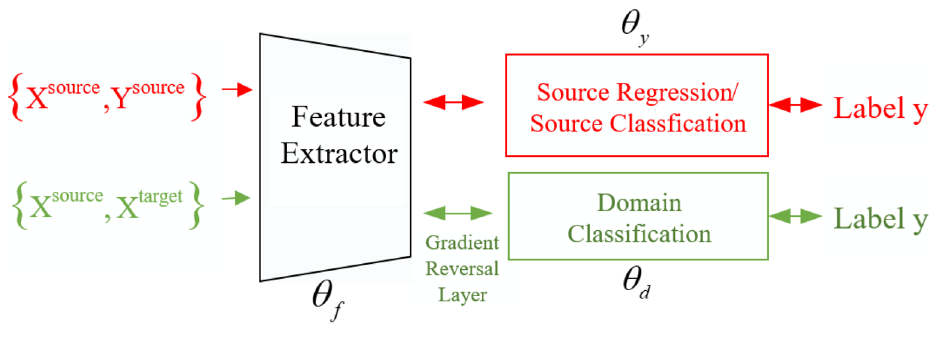
Figure 1. The architecture of